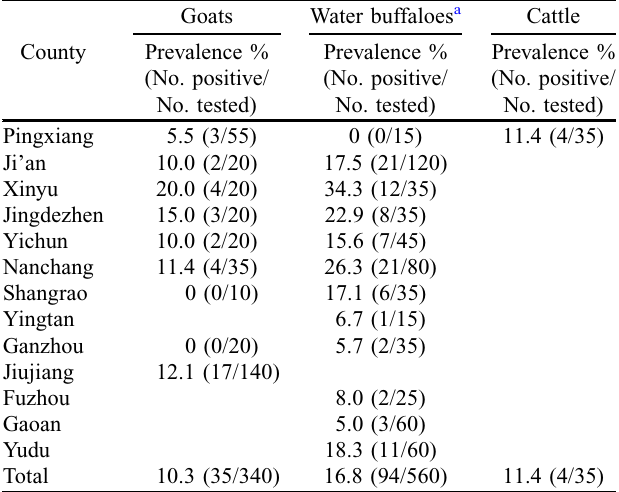
Table 1. Prevalence of Toxoplasma gondii infection in zoo animals determined by indirect hemagglutination in Jiangxi province, China in 2016.